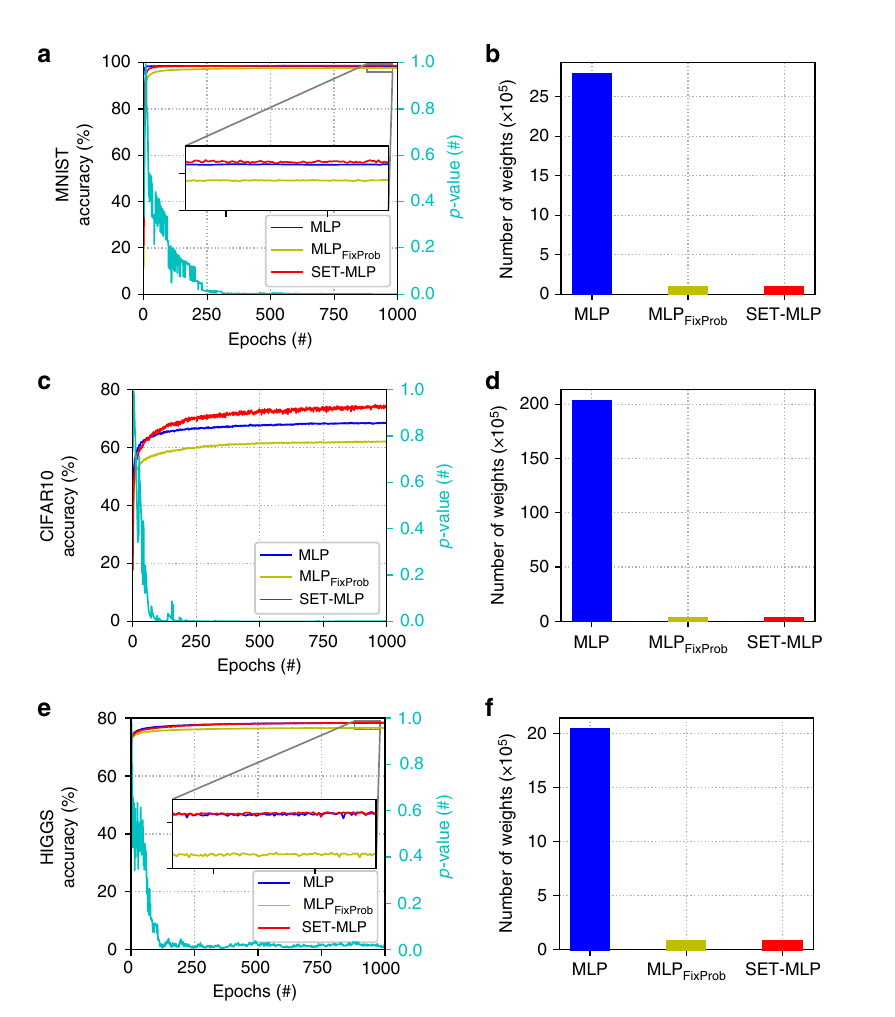
Fig. 5 Experiments with MLP variants using three benchmark datasets. a , c , e re fl ect models performance in terms of classi fi cation accuracy (left y axes) over training epochs ( x axes); the right y axes of a , c , e give the p -values computed between the degree distribution of the hidden neurons of the SET-MLP models and a power-law distribution, showing how the SET-MLP topology becomes scale-free over training epochs. b , d , f depict the number of weights of the three models on each dataset. The most striking situation happens for the CIFAR10 dataset ( c , d ) where the SET-MLP model outperforms drastically the MLP model, while having ~100 times fewer